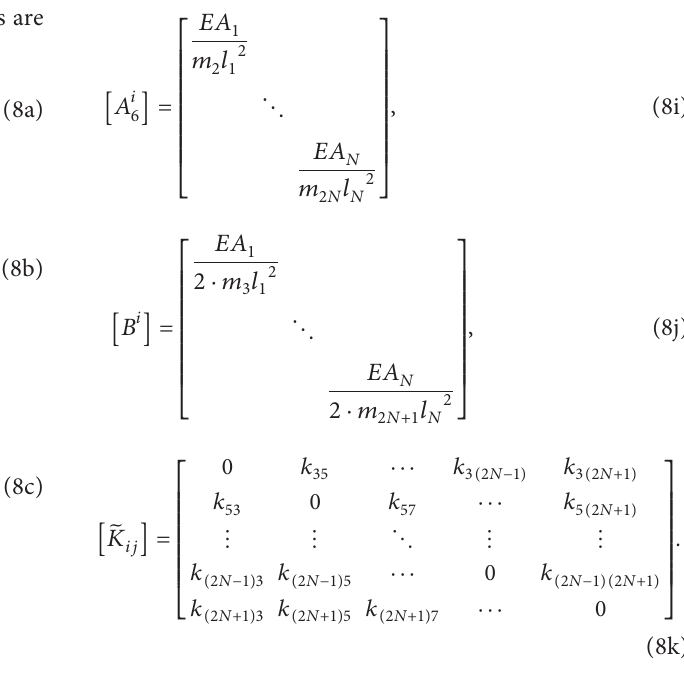
Stiffness Effect of the Beam. Generally, the length and the tension of the cable are changed periodically, promoting that the bending stiffness of the cross section of each beam portion is a nonlinear equation varied with time. It is too complex to solve or simulate the differential equations of the nonlinear resonance. To address this issue, the shear dif- ference obtained from the finite difference is applied to simulate the interaction between adjacent beam portions. Figure 5 takes the beam portion of the i th ( i ∈ [2, N − 1]) subsystem under an undamped condition as an example. In Figure 5, the spring k represents the effect of the 2 i +1 bending stiffness for i th beam portion; V and 2 i − 1,2 i +1 V represent the shear force value on each side of this 2 i +1,2 i +3 beam portion in this subsystem. The curvature of this beam portion can be approximately represented by the two-order central difference value of this beam portion: